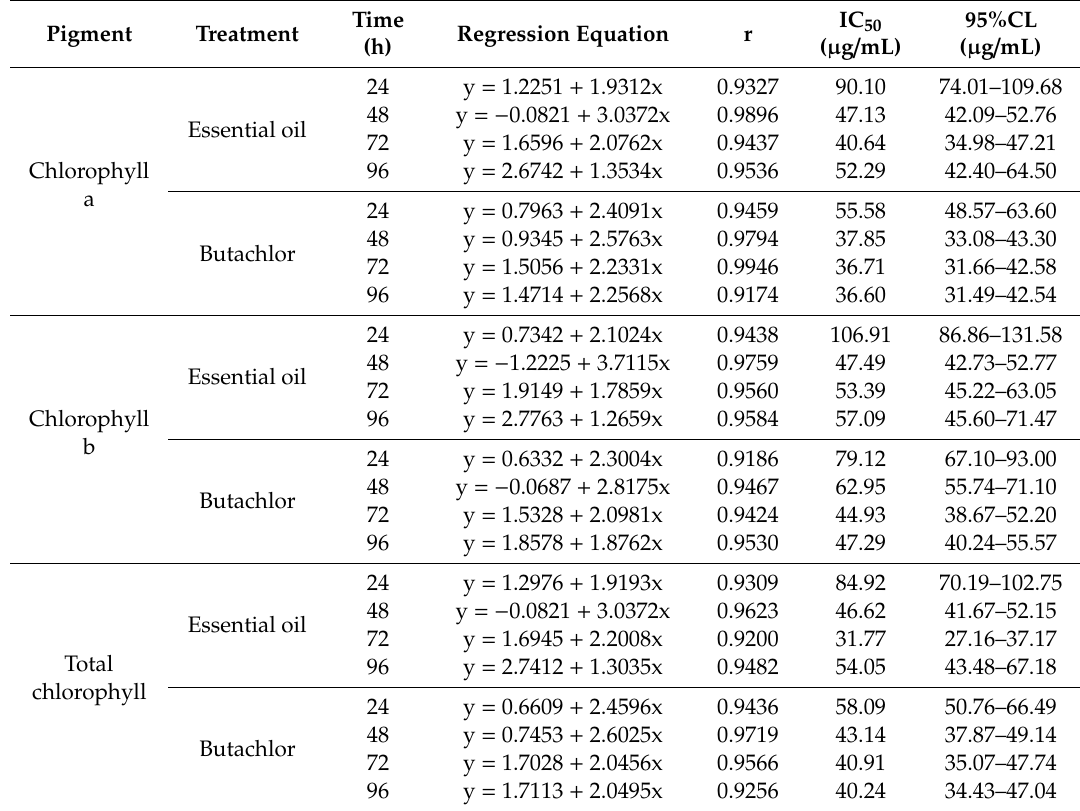
Table 2. IC 50 of T. flousiana essential oil and butachlor on the content of chlorophyll a, chlorophyll b, and total chlorophyll of S.